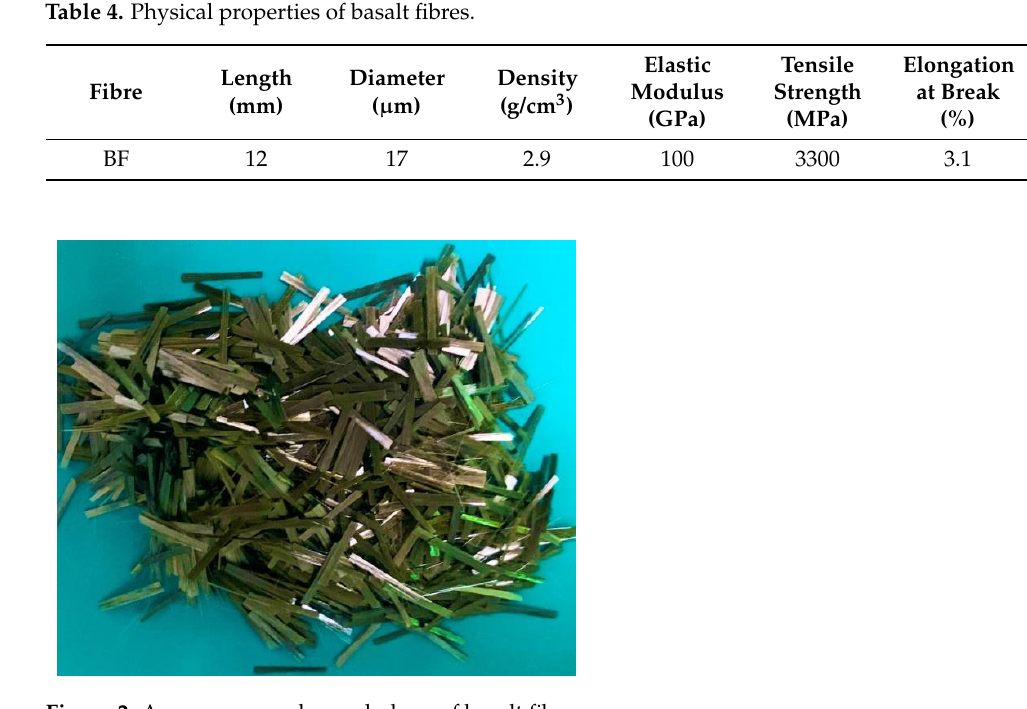
Figure 2. Appearance and morphology of basalt fibres. Table 5. Mixing proportions of mortar mixtures (kg/m 3 ).